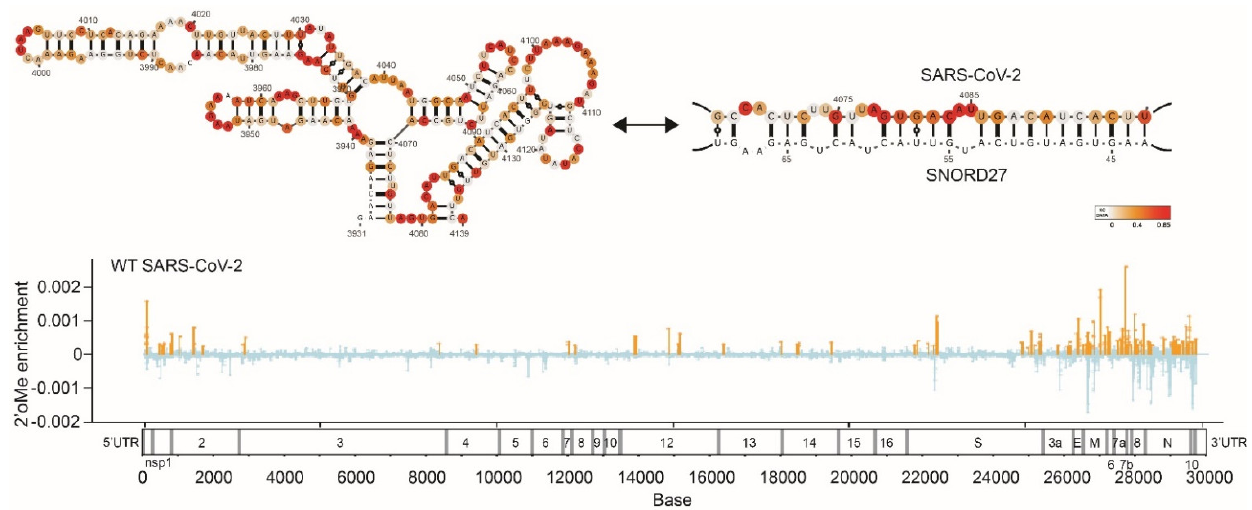
Figure 2. Top , SARS-CoV-2 structure models when the SARS-CoV-2 genome does not interact or interacts with SNORD27. SHAPE reactivity was used for constraints in this model. Bottom , locations of 2′-O-methylation sites found along SARS-CoV-2 genome. Image retrieved from an open